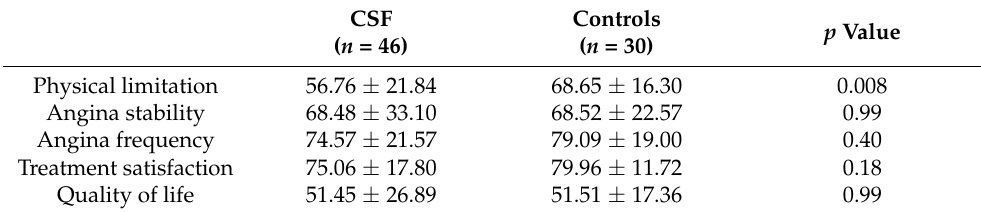
Table 2. Comparison of Seattle Angina Questionnaire.